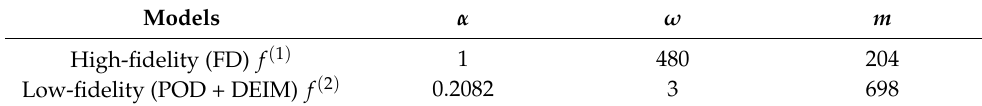
Table 1. Number of samples per model, coefficients and costs for NLS equation.